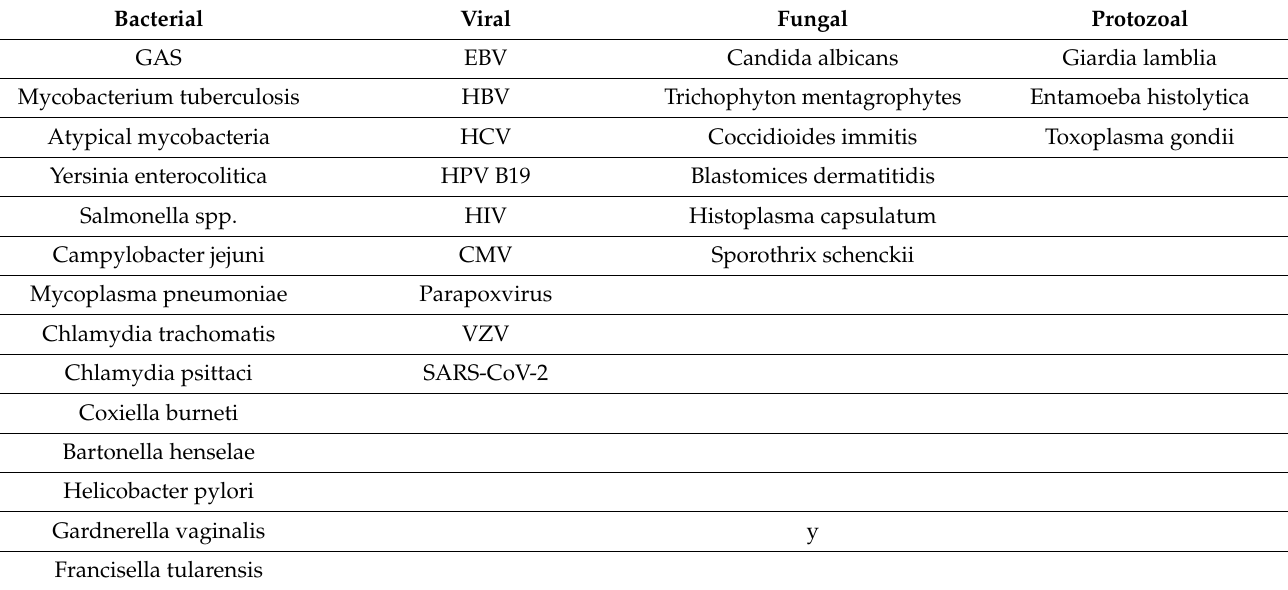
Table 3. Infectious causes of erythema nodosum in children